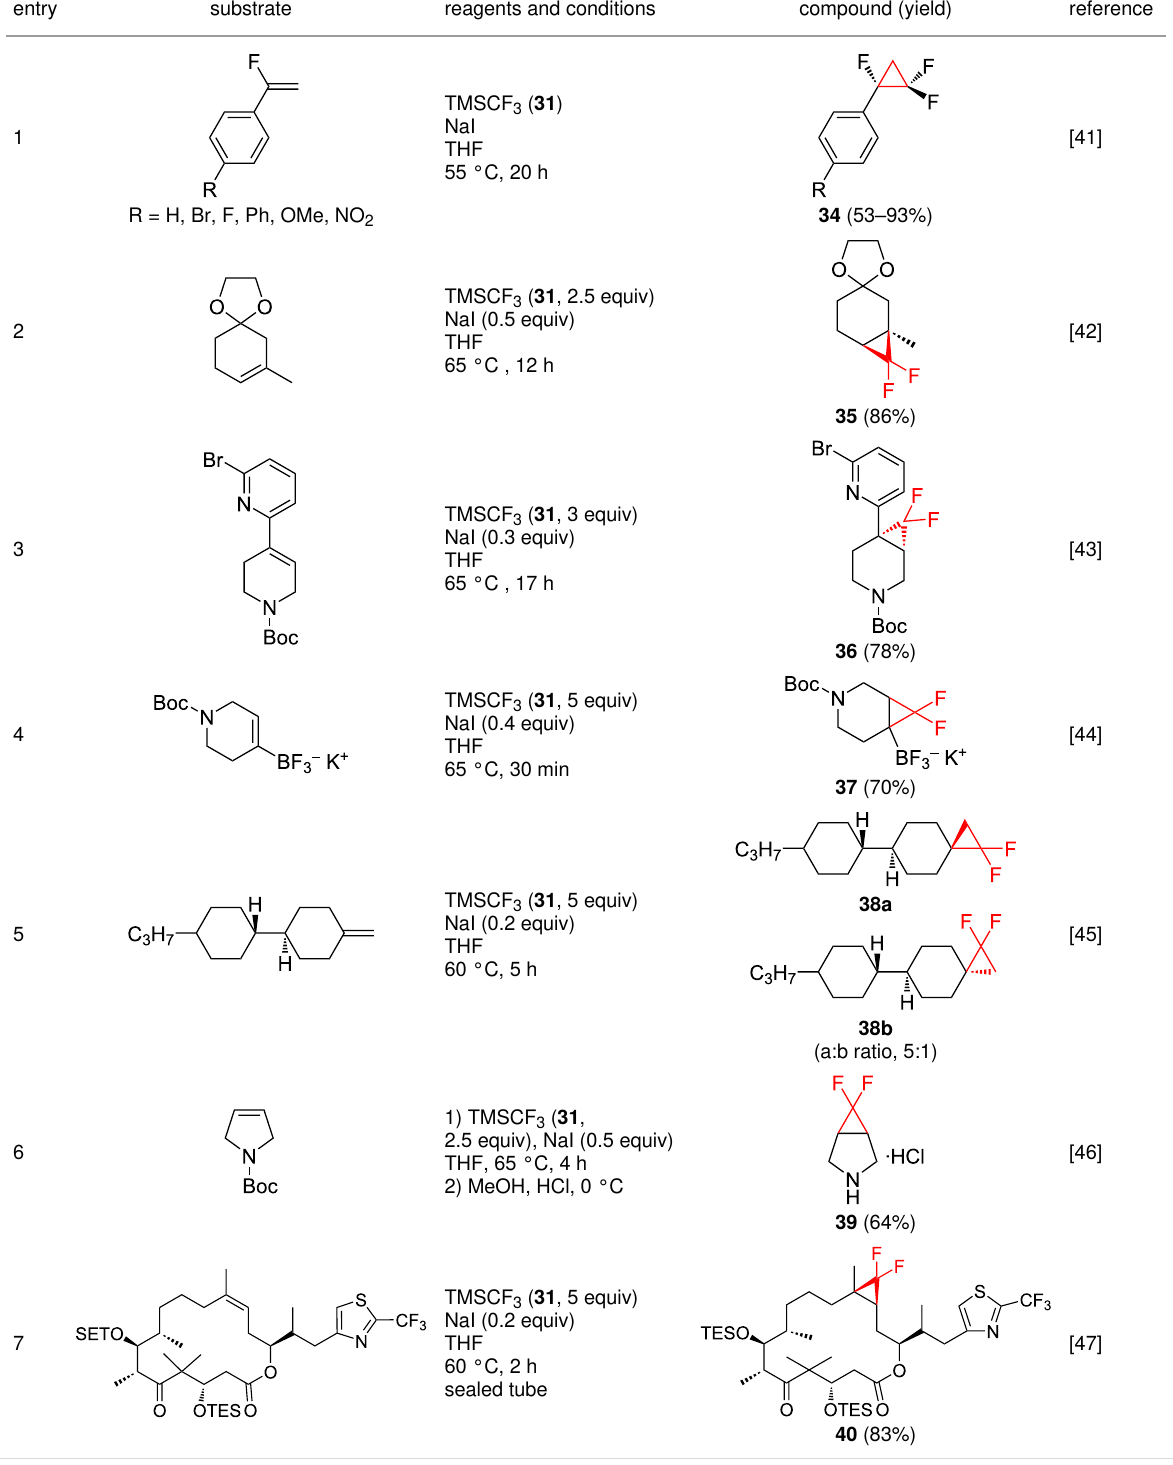
Table 2: The synthesis of gem -difluorocyclopropanes using TMSCF 3 ( 31 ) as the carbene source in combination with sodium iodide as initiator.